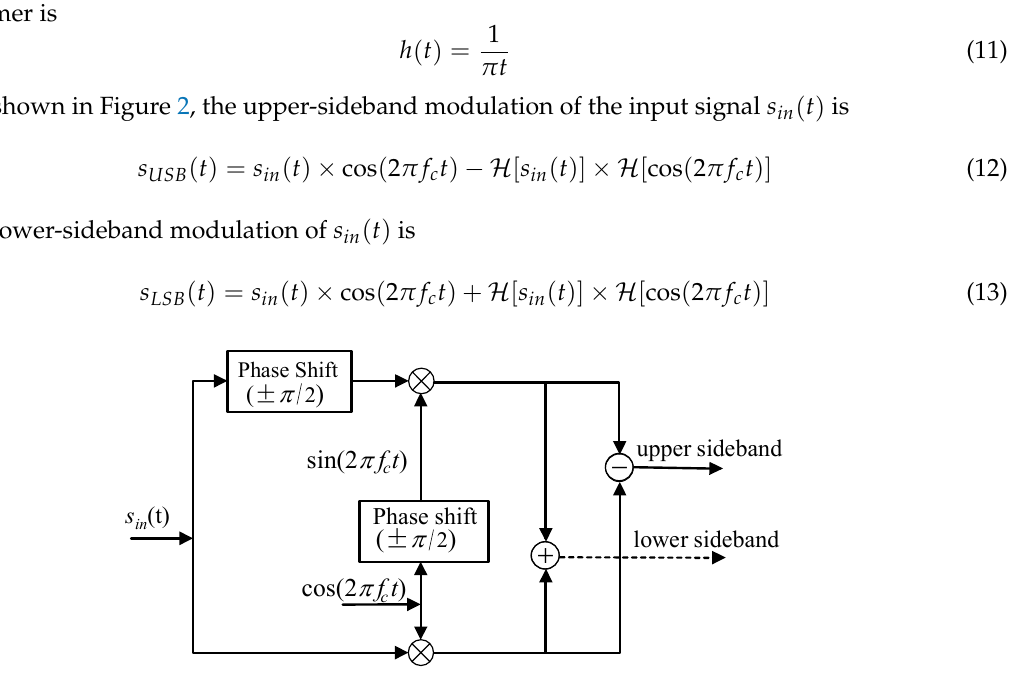
Figure 2. Schematic diagram of single-sideband modulation.